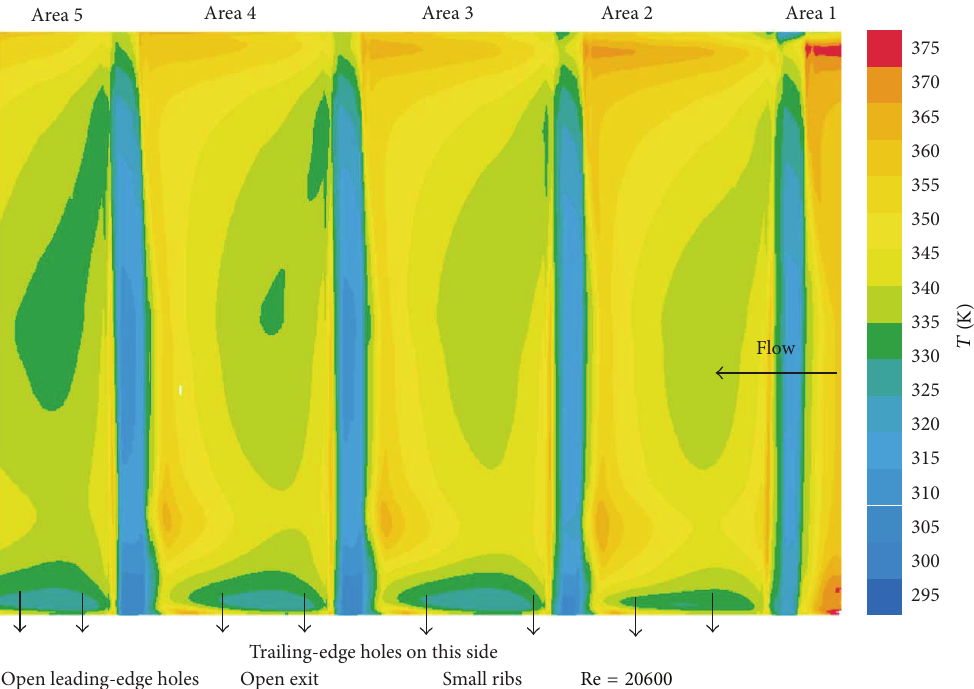
Figure 14: Contours of surface temperature on Areas 2 through 5 on the concave wall, open trailing-edge holes, open exit, small ribs.